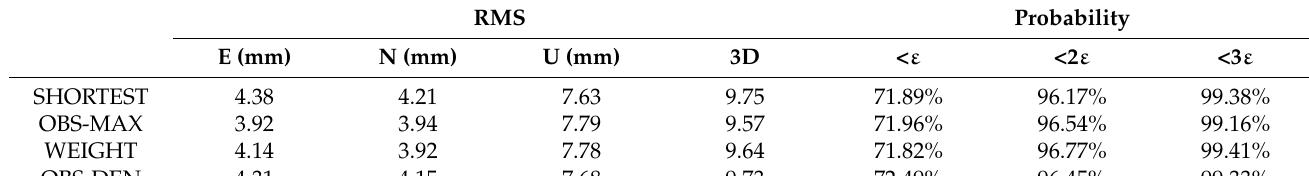
Table 2. Statistics of one-year solutions. The left side represents the RMS, and the right side represents the probability that the 3D errors for each method exceed certain thresholds. The threshold ε is set as 9.67 mm, which is the average 3D RMS value of the four methods.